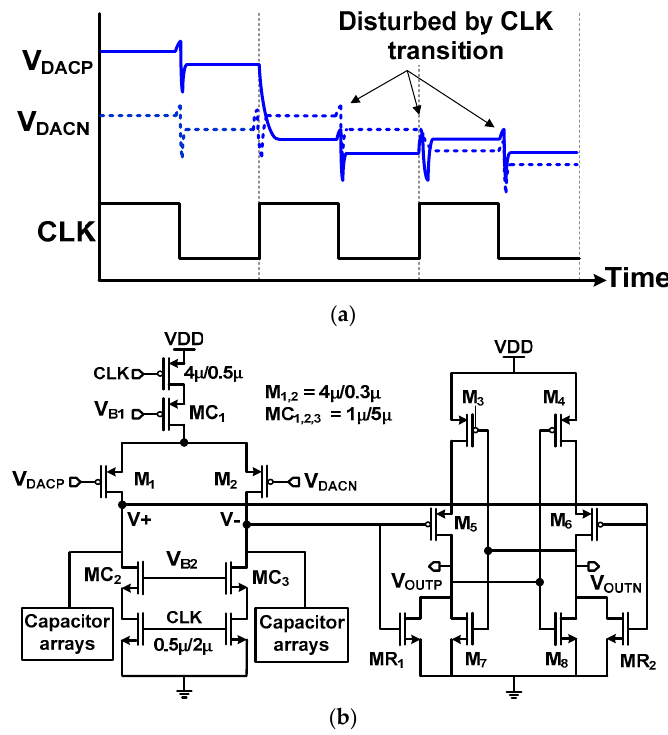
Figure 2. ( a ) Waveform showing the generation of the kick-back noise by the clocked operation. ( b ) Schematic of the comparator using cascode to reduce the kick-back. ( b ) Schematic of the comparator using cascode to reduce the